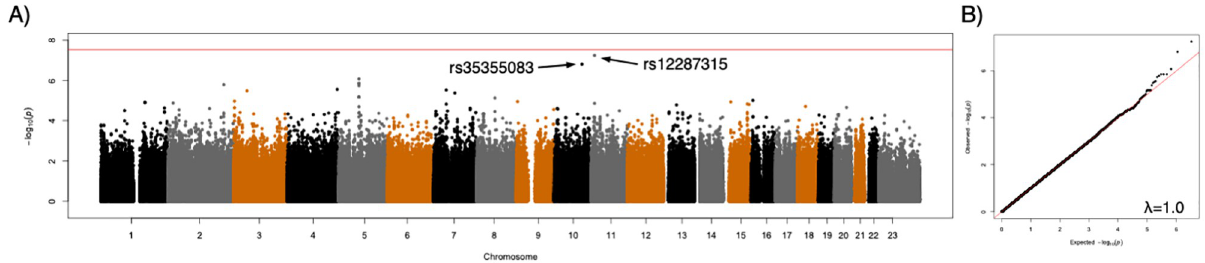
Fig 2. Results of genome-wide association study of certolizumab pegol response, as measured by DAS28 (week 12) scores. (A) Manhattan plot of significance scores from linear regression analysis. (B) Quantile-quantile plot of observed significance scores vs expected under the null hypothesis. The red line indicates the Bonferroni-adjusted threshold for statistical